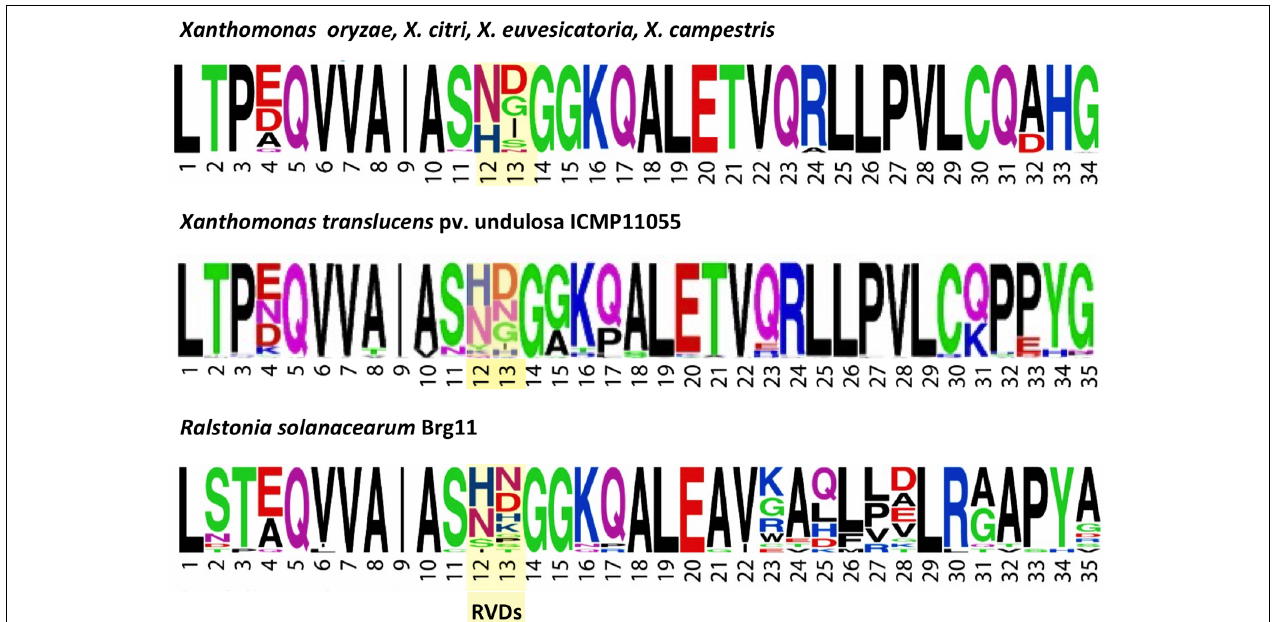
FIGURE 5 | Amino acid sequence motifs of TALEs of X. translucens pv. undulosa strain ICMP11055 relative to TALEs of other Xanthomonas species and a RipTAL of Ralstonia solanacearum . WebLogos (Crooks et al., 2004) illustrate the frequency of individual amino acids (by letter height, using the single letter code) at each position across the repeats of TALEs from representative strains of (top) X. oryzae , X. citri , X. euvesicatoria , and X. campestris , (middle) the TALEs of X. translucens pv. undulosa ICMP11055, and (bottom) RipTAL Brg11 of Ralstonia solanacearum . The RVD positions are highlighted. The WebLogo for the ICMP11055 TALEs was generated in this study. The others were published previously (Schornack et al., 2013) and are used with permission of Annual Reviews; permission conveyed through Copyright Clearance Center, Inc.